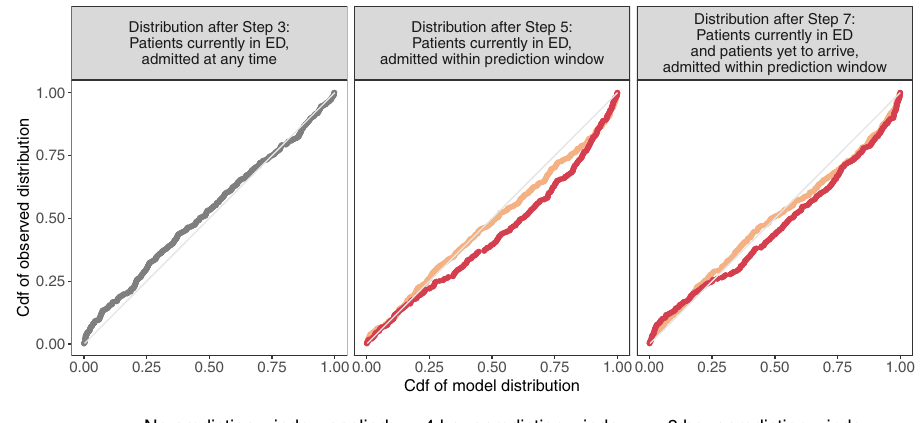
Fig. 5 QQ plots evaluating the predicted distributions of the number of admissions after Steps 3, 5 and 7. Abbreviations: cdf (cumulative distribution function). The fi rst column of plots evaluates the distributions for all patients currently in the ED, without applying a prediction window. The second column evaluates the distributions for all patients currently in the ED, with a prediction window of 4 and 8 hours. The third column evaluates the distributions for all patients currently in ED, and patients yet to arrive, with a prediction window of 4 and 8 hours.